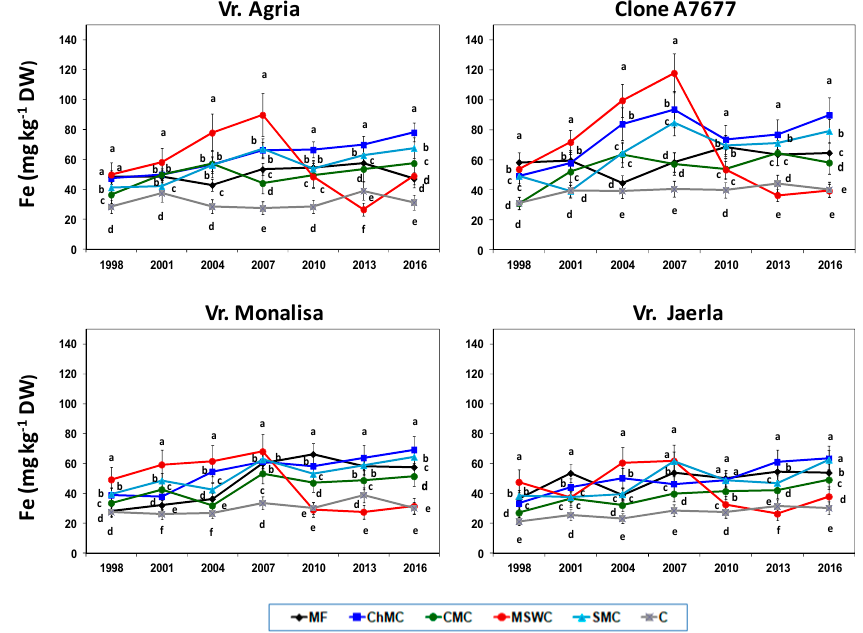
Figure 6. Evolution of the potassium content (g kg − 1 DW DW) in potato tubers of the Agria, Monalisa, Jaerla and clone A7677 varieties (1998–2016) versus the application of compost from different organic amendments. The means with different lowercase letters within each season indicate significant differences between the treatments ( p < 0.001). Bars stands for standard deviations. MF: mineral fertilizer; ChMC: chicken manure compost; CMC: cow manure compost; MSWC: municipal solid waste compost; SMC: sheep manure compost; C: control.